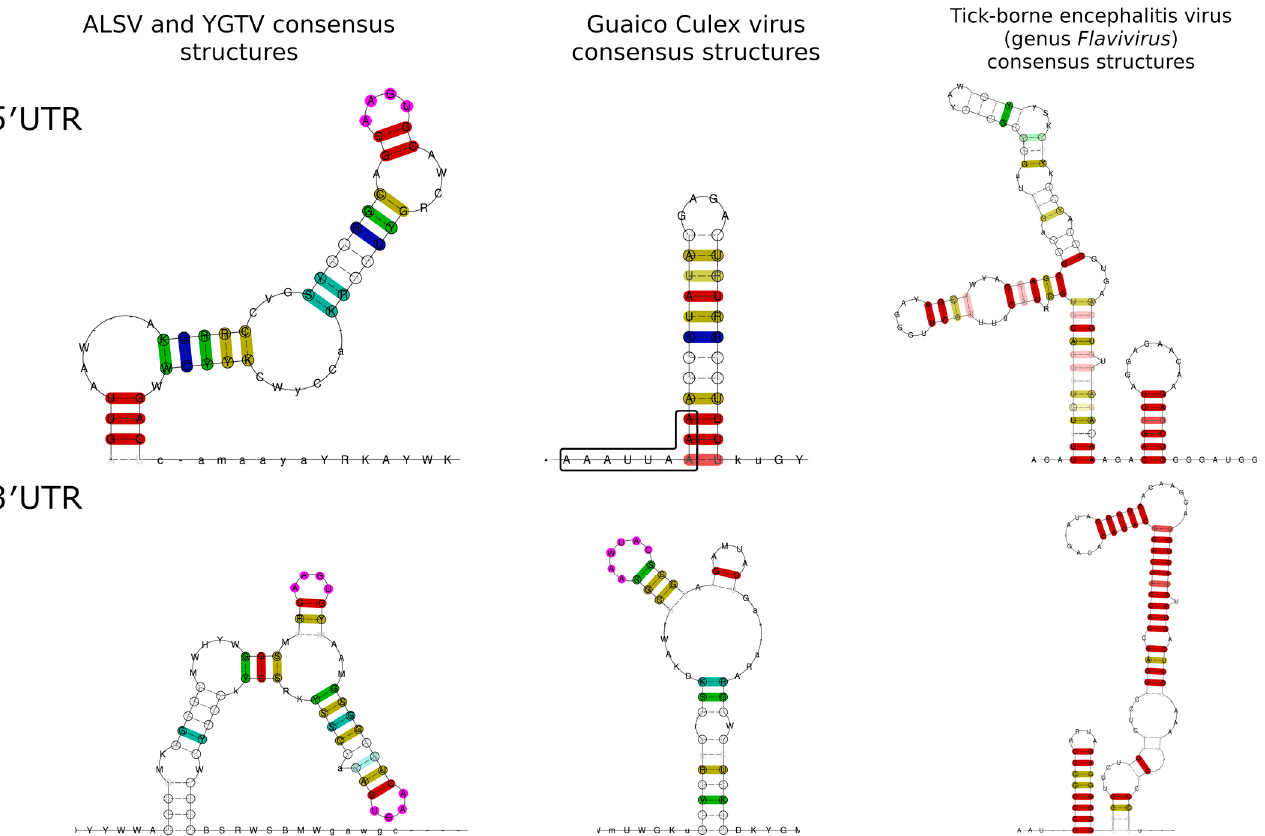
Figure 5. Comparison of the predicted secondary structures of the ALSV and YGTV and GCXV and and tick-borne encephalitis virus (genus Flavivirus ). Conserved 5 (cid:48) UTR nucleotides of the GCXV are tick-borne encephalitis virus (genus Flavivirus ). Conserved 5 ′ UTR nucleotides of the GCXV are marked by black box. For the construction of the GCXV 3 (cid:48) UTR structure, only segment 1–4 sequences marked by black box. For the construction of the GCXV 3 ′ UTR structure, only segment 1–4 se- were used. Conserved 3 (cid:48) UTR loop of the GCXV is marked in purple. For the construction of TBEV 3 (cid:48) quences were used. Conserved 3 ′ UTR loop of the GCXV is marked in purple. For the construction UTR structure, 109 terminal nucleotides were of TBEV 3 ′ UTR structure, 109 terminal nucleotides were used.